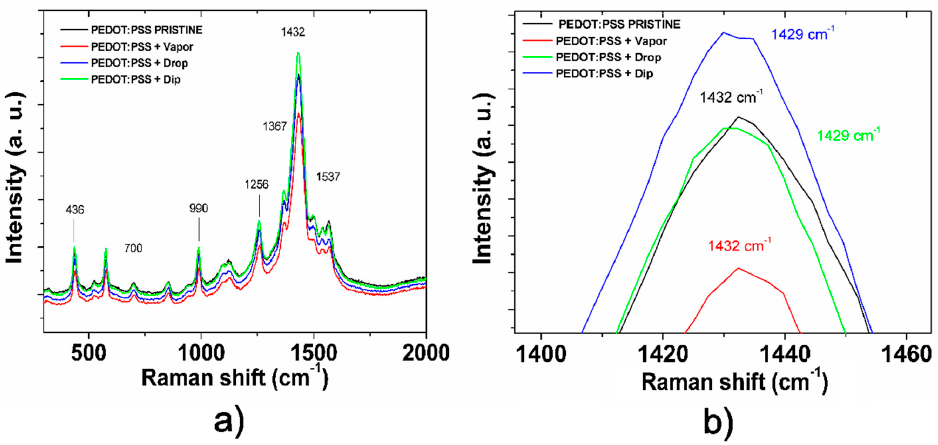
Figure 9. ( a ) Raman spectra of pristine PEDOT:PSS film post-treated IPA PEDOT:PSS films using VAPOR, DROP, and DIP techniques. ( b ) Close view of Raman band associated to C=C symmetrical stretching intramolecular vibration of PEDOT between 1400 and 1460 cm − 1 (benzoid/quinoid forms).